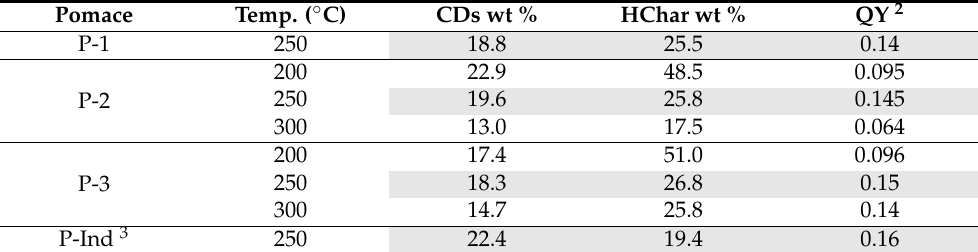
Table 3. Mass yields of as-synthesized CDs and hydrochars (HChar), and the corresponding CDs’ quantum yields 1 . Pomace Temp. ( ◦ C) CDs wt % HChar wt % QY 2 P-1 250 18.8 25.5 0.14 200 22.9 48.5 0.095 250 19.6 25.8 0.145 P-2 300 13.0 17.5 0.064 200 17.4 51.0 0.096 250 18.3 26.8 0.15 P-3 300 14.7 25.8 0.14 P-Ind 3 250 22.4 19.4